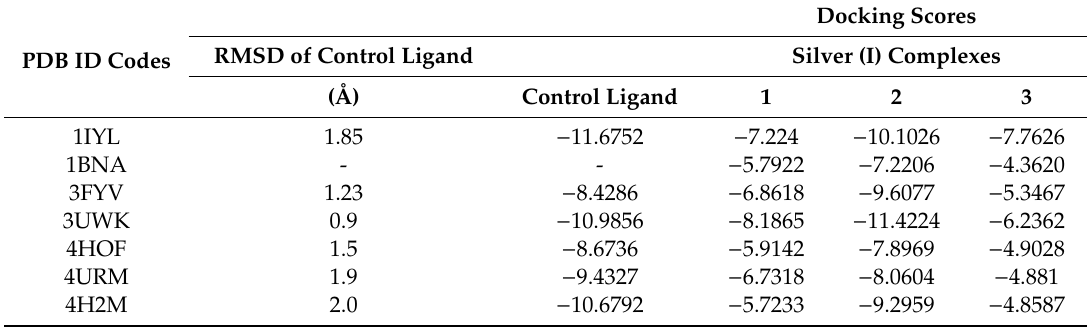
Table 3. Root-mean-square deviation (RMSD) and predicted binding a ffi nity (docking scores in kcal / mol) of control inhibitor and silver complexes against target